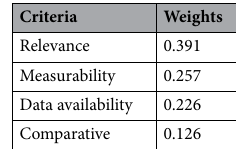
Table 3. Normalized weights of the criteria.